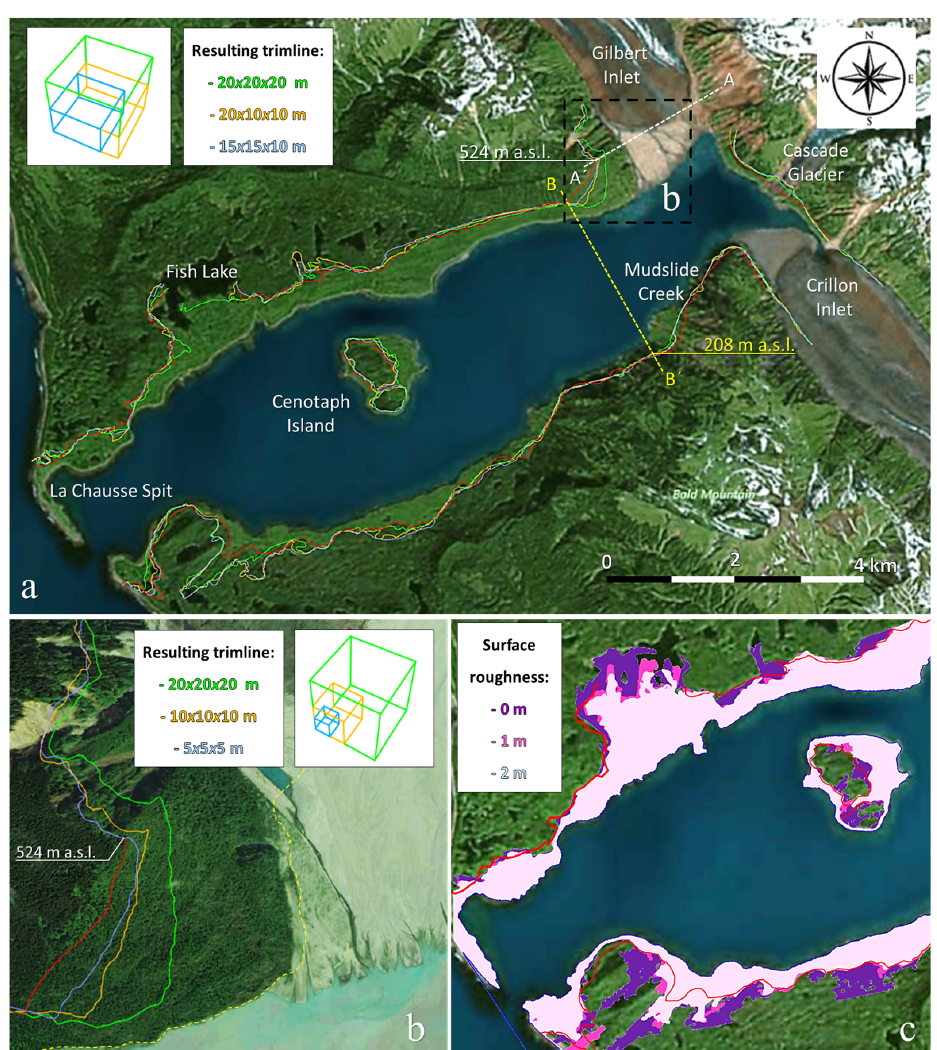
Figure 12. (a) Different results of the inundated area and the related trimline, with respect to the observed data (red line), for different grid resolutions and relative roughness equal to 0m. Sections are reported in Fig. 13. (b) At Gilbert Inlet, the resulting trimlines are defined from the grid resolutions used for the impact area simulations (20, 10, 5m) and relative roughness is equal to 0m. The dashed yellow line represents the shoreline before the tsunami event. (c) The resulting inundation area varies depending on the selected relative roughness of 0, 1, or 2m for the topographic surface (background topography from © Google Earth Pro 7.3.2.5776; last access: 24 April